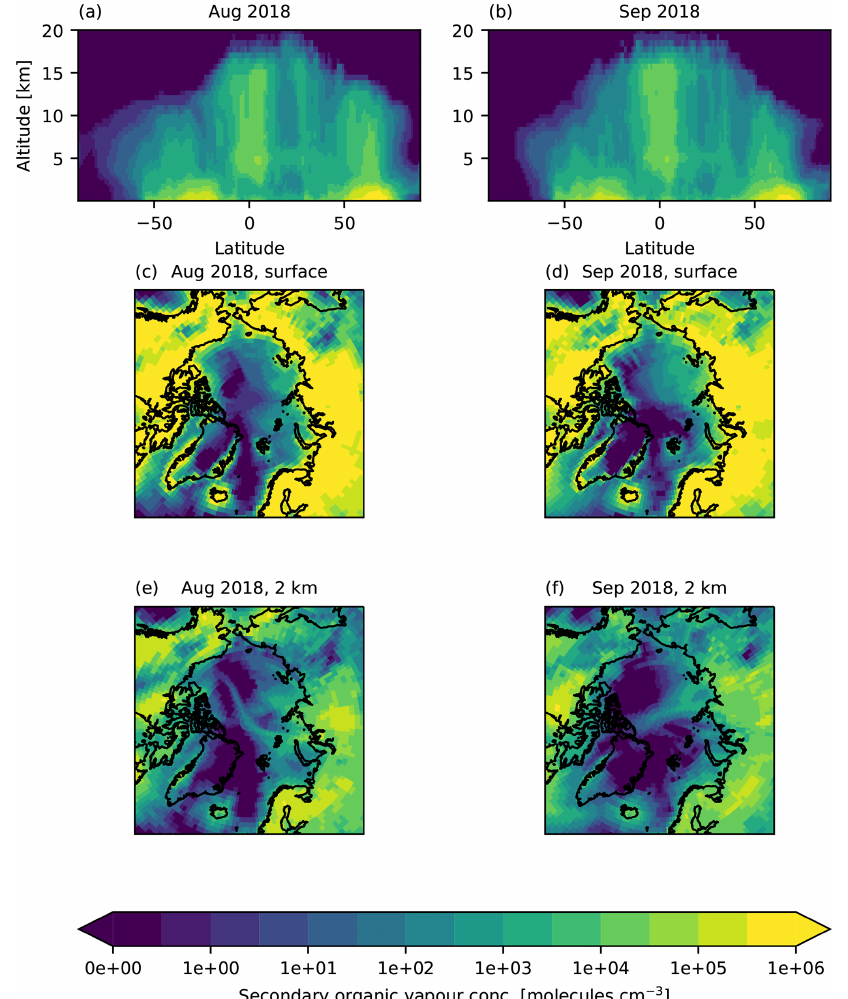
Figure E4. Zonal means and maps of simulated monthly mean secondary organic vapour concentration from simulation CONTROL. Maps are taken from model level (c–d) sat surface and (e–f) with altitude